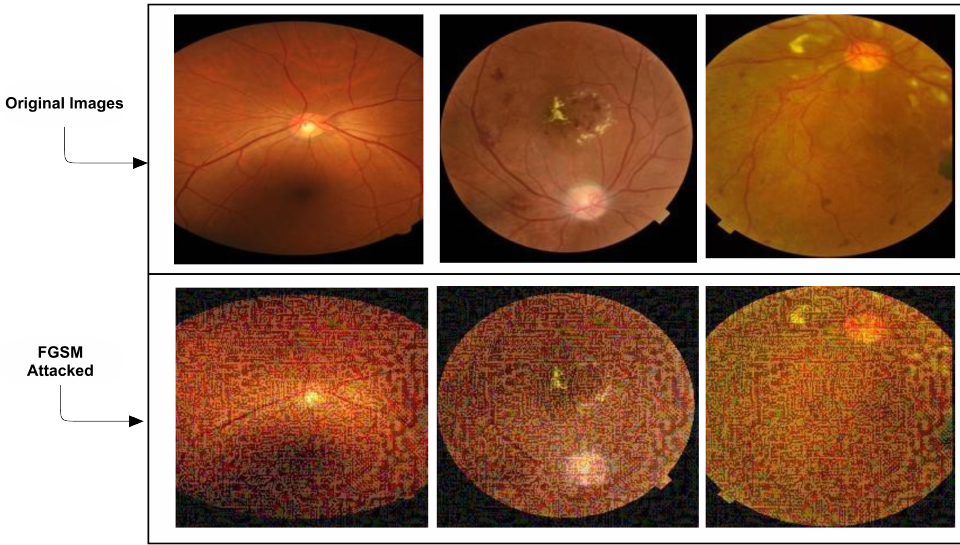
Figure 2. Addition of FGSM Attacks. The first row shows the original images, while the second row represents the FGSM attacked images that mislead the